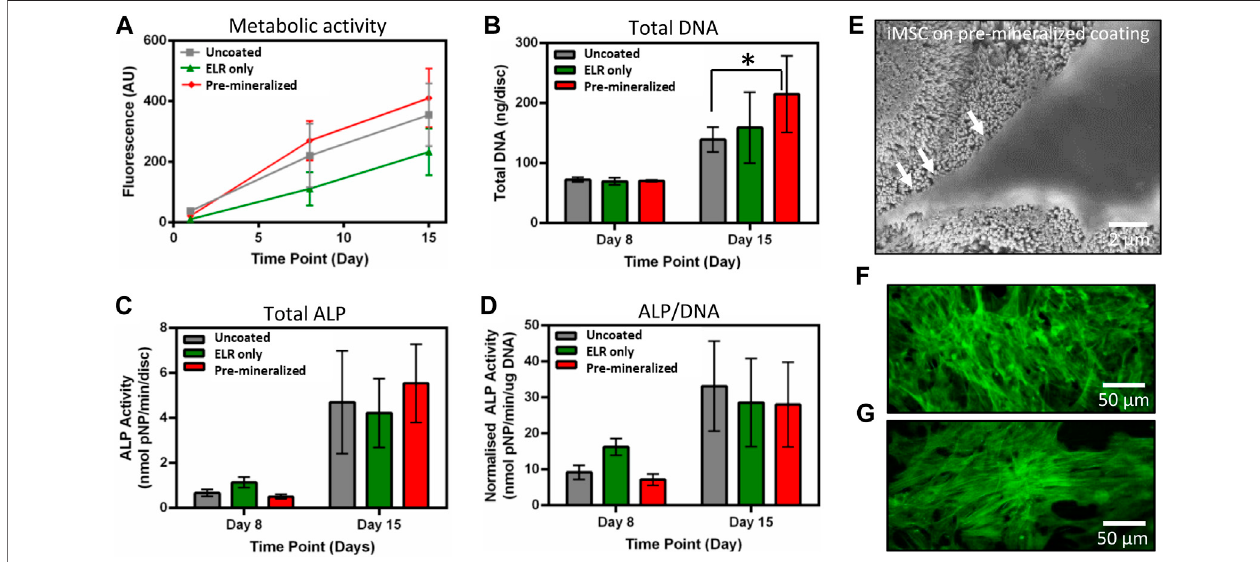
FIGURE 2 | In vitro characterization. (A) Metabolic activity, (B) total DNA, (C) total ALP, and (D) normalized ALP activity of hiMSCs on different test samples. (E) SEM micrographsof hiMSCs after 5 days of culture on “ Pre-mineralized ” samples depicting cell protrusions (as pointed byarrow heads) that indicate cell spreadingand migration, and fl uorescence microscopic imagesofhiMSCs cultured for5 days on (F) “ Pre-mineralized, ” and (G) “ ELRonly ” coated samples.Datapresented atmean± SD ( n = 6). In (B) * represents signi fi cant difference p < 0.05 between “ Uncoated ” and “ Pre-mineralized ” scaffold, estimated using one-way ANOVA in GraphPad Prism ver. 6